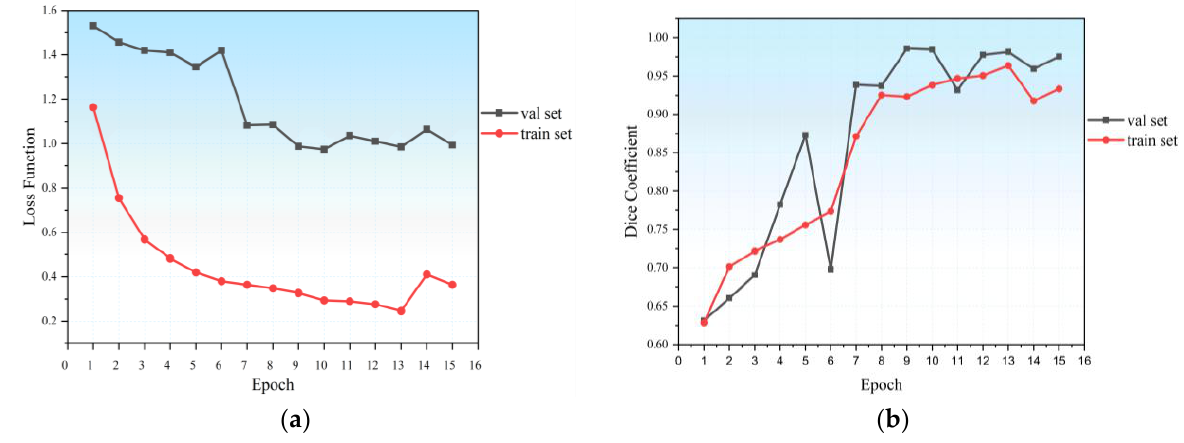
Figure 6. ( a ) Loss function of SegTGAN on Kits19; and ( b ) Dice coefficient of SegTGAN on Kits19.